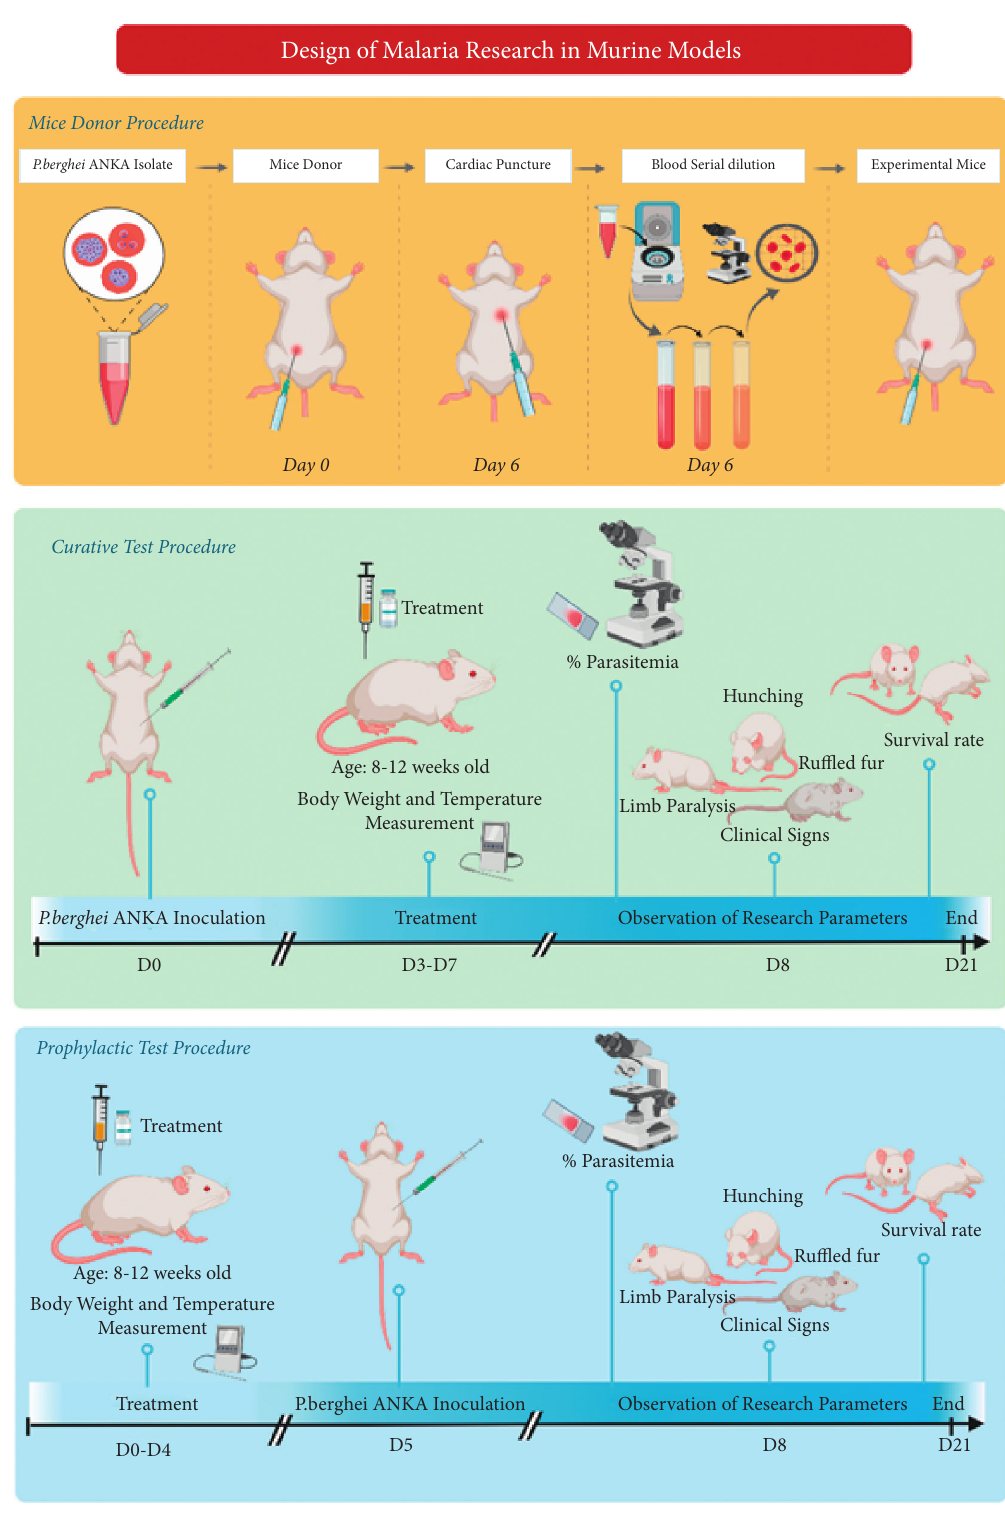
Figure 1: Malaria research design using murine